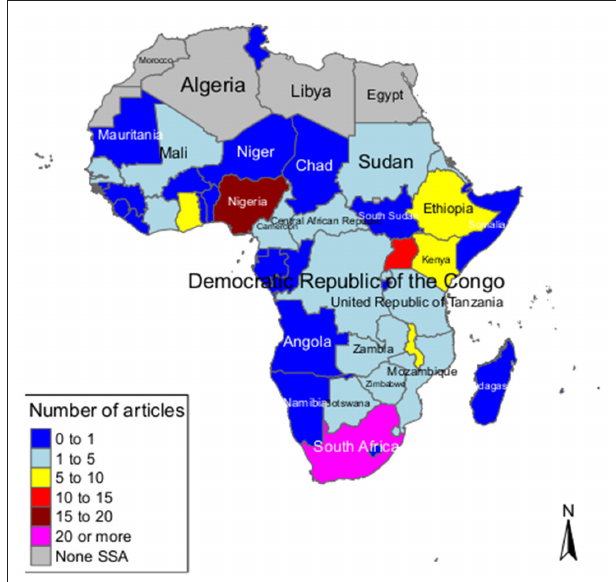
FIGURE 4 | Map showing spatial distribution of studies on breast, cervical and prostate cancer in Sub-Saharan Africa (global and multi-country studies were not included on the map).